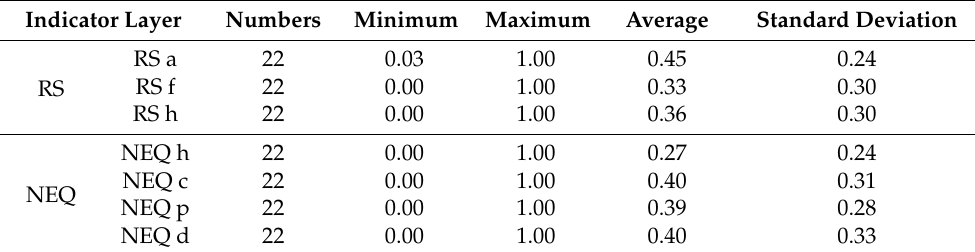
Table 2. Descriptive statistics of waterfront